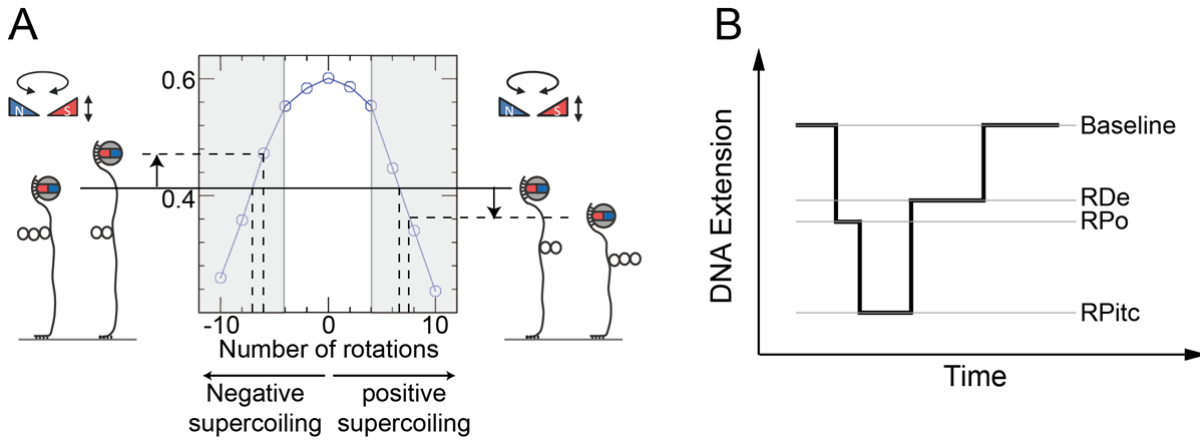
FIGURE 5: Single molecule DNA nanomanipulation. (A) Extension vs. supercoiling curve for a single tethered DNA molecule. A schematic diagram of the magnetic trap is provided, showing a pair of trapping magnets located above a coverslip-bound DNA molecule tethered at one end to a magnetic bead. (B) Real-time detection of transcription. A succession of three states (RNAP-promoter open complex, RPo; RNAP-promoter initially-transcribing complex, RPitc; and RNAP-DNA elongation complex, RDe) can be identified corresponding to the dif- ferent stages of transcription. RPo is oftentimes too short-lived to be observed in the presence of high concentrations of nucleotides, as RNAP can begin transcribing in those conditions. The initial baseline state, in which no RNAP is actively unwinding the DNA, is recovered upon transcription termination once the RDe complex reaches the transcription termination sequence and is ejected from the